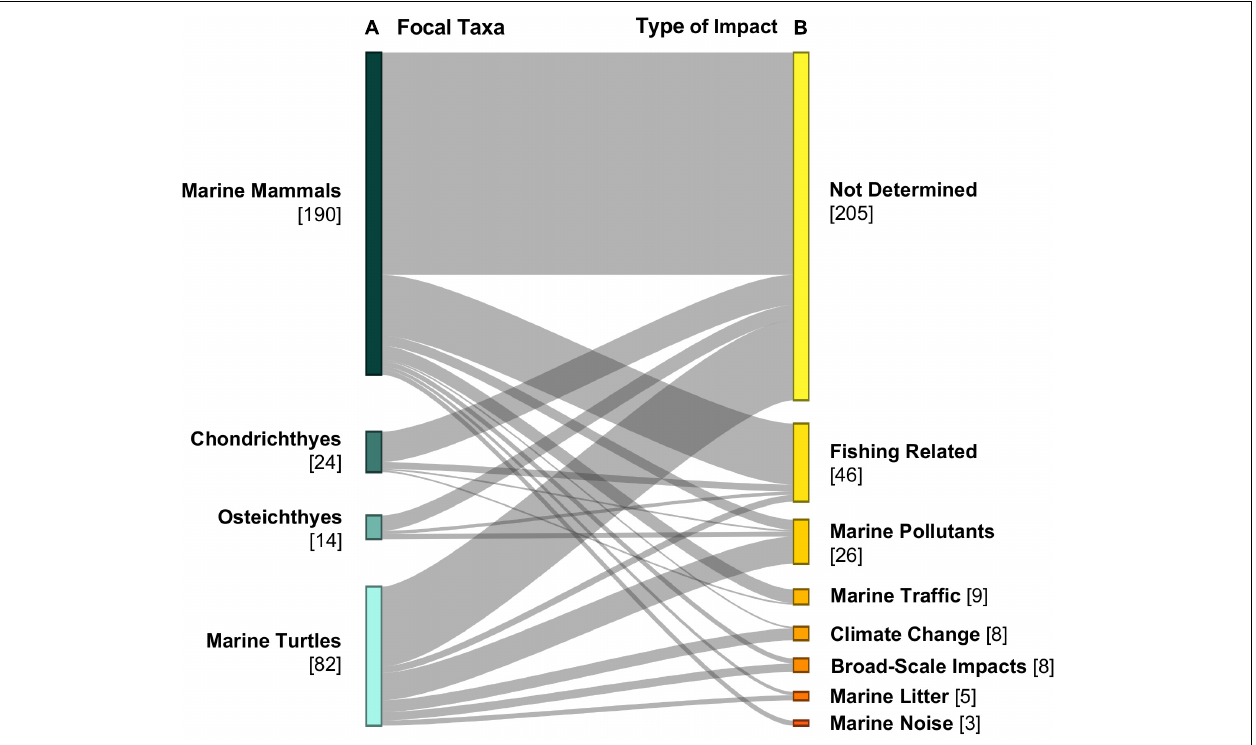
FIGURE 6 | Sankey diagram depicting (A) the number of publications that quantify (B) anthropogenic impacts on Macaronesia marine megafauna in relation to the focal taxa of study.